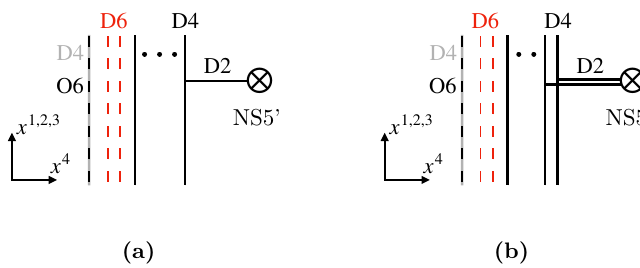
Figure 7. (a): a realization of the ’t Hooft operator corresponding to the minimal representation V and B = e n in the SQCD or the N = 2 ∗ theory. In the N = 2 ∗ case, the D6-branes should be omitted, and the O6-plane that intersects an NS5-brane is present in the system but suppressed in the figure. The D4-brane on top of the O6-plane, indicted by the gray line, is present only for the gauge group SO(2 n + 1) . (b): a realization of the ’t Hooft operator corresponding to ∧ 2 V and B = e n − 1 + e n